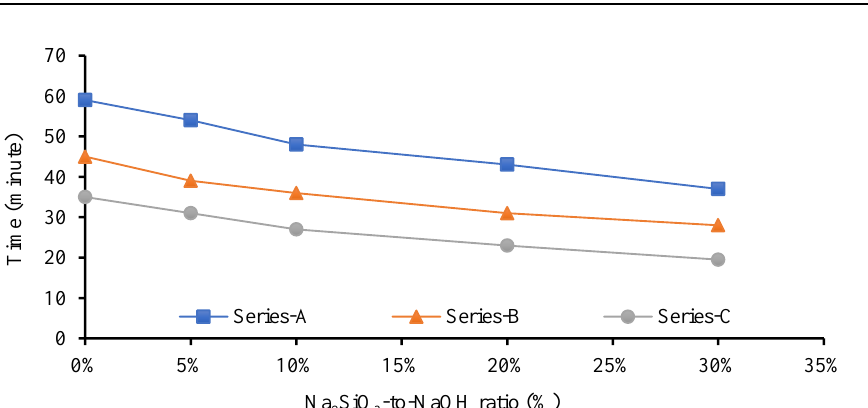
Figure 14. Geopolymer material initial setting time using various Na 2 SiO 3- to-NaOH and FA-to- GGBS ratios with sand preheated at 110 °C.